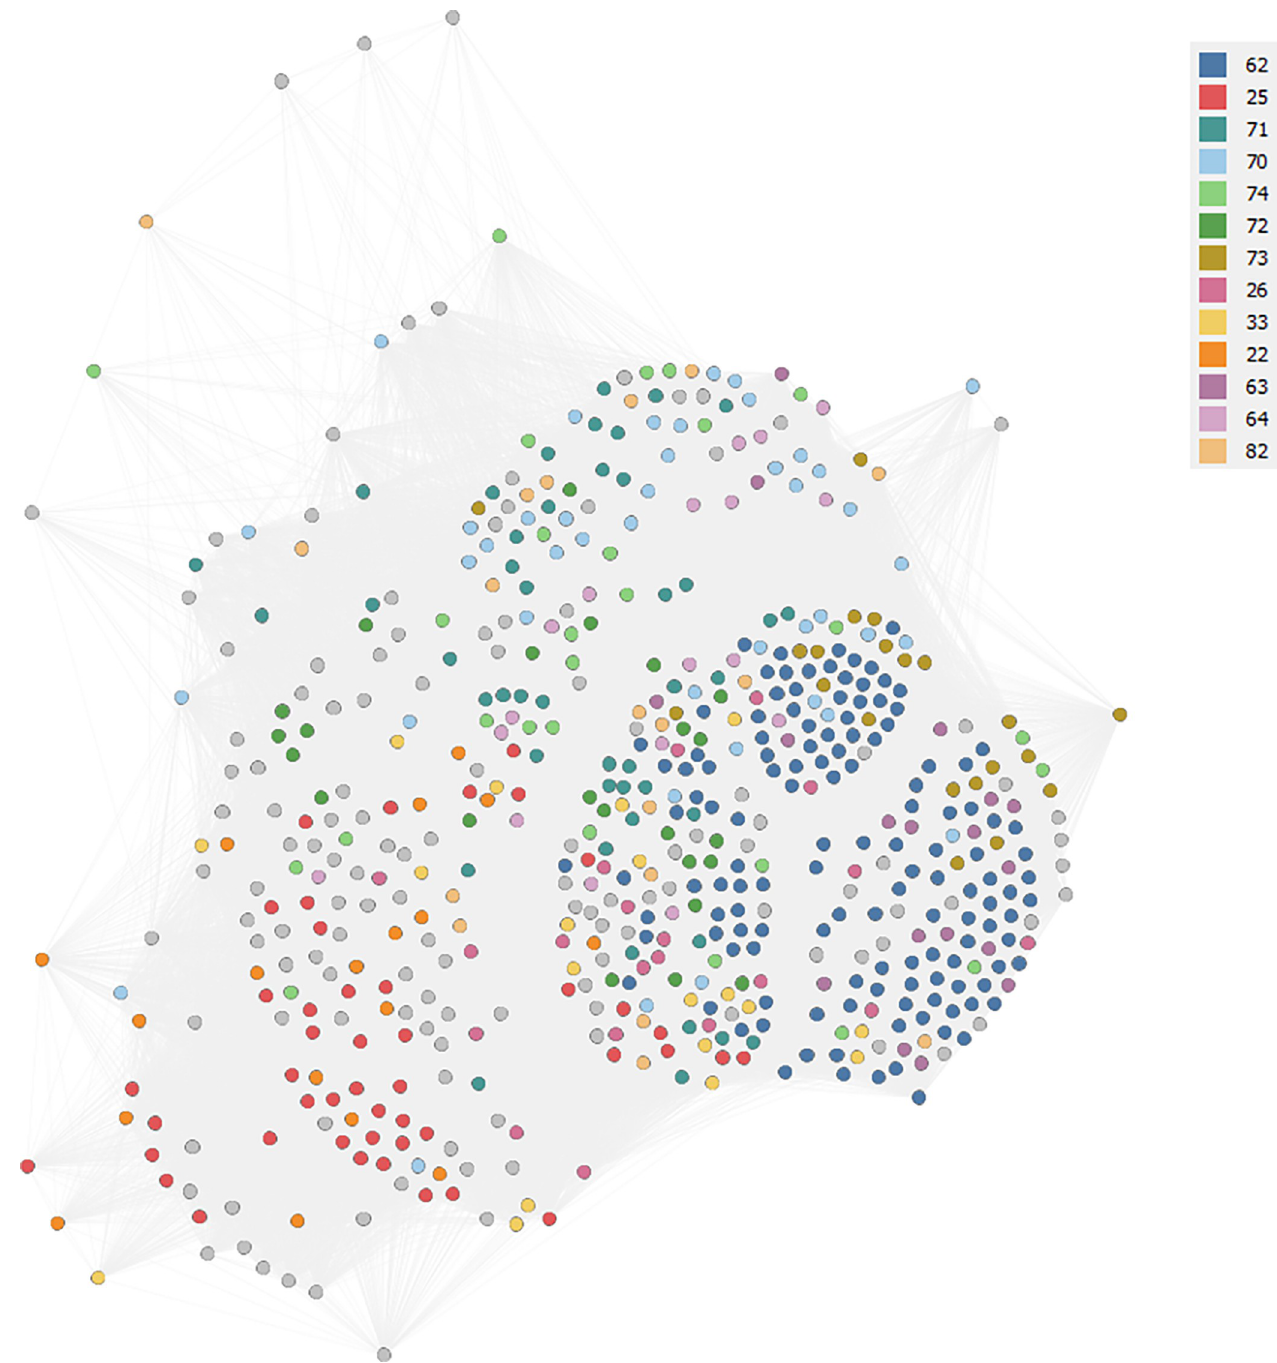
Fig 3. A network based on co-occurrence of tags between firms in Chieti and